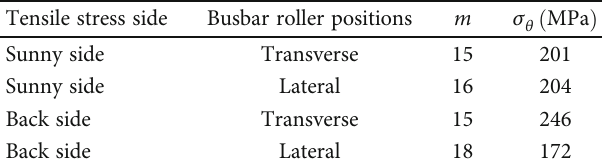
Table 3: Weibull parameters of strength with 90% con fi dence bounds were obtained by four-point bending experiments using solar cells in various con fi